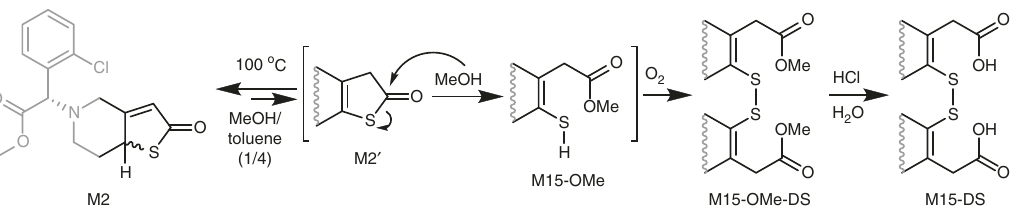
Fig. 2 Chemical preparation of M15 disul fi de (M15-DS) from the stable bioactivation intermediate M2. The heat-promoted double-bond migration in M2 is followed by thiolactone cleavage and disul fi de formation